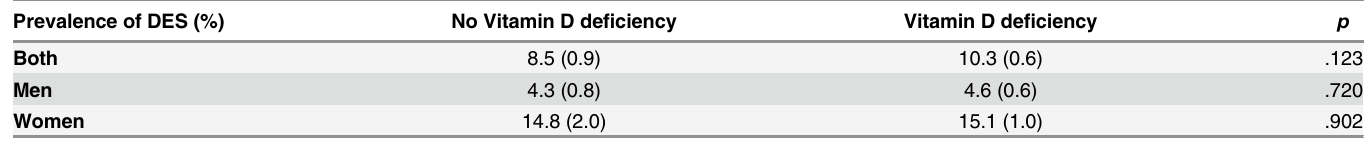
Table 5. Prevalence of dry eye syndrome (DES) in subjects with or without vitamin D deficiency (25-hydroxyvitamin D < 20 ng/mL). Prevalence of DES